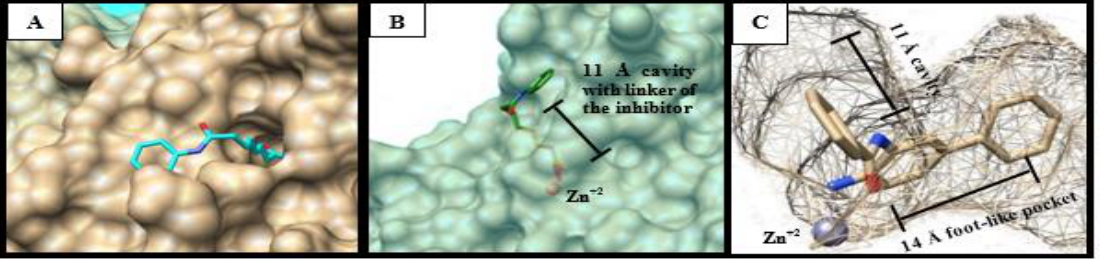
Figure 1 .The binding site of HDAC2. (A): The opening of the tunnel cavity is shown in which the linker of the inhibitor (cyan) is lying. (B): A side view of the binding site with 30% transparency of the surface to make the whole length of the tunnel (11 Å) visible together with the linker of the inhibitor (forest green). Zinc ion is visible at the deepest end of the tunnel. (C): Mesh surface of the binding site showing the inhibitor inside the 14 Å foot-like